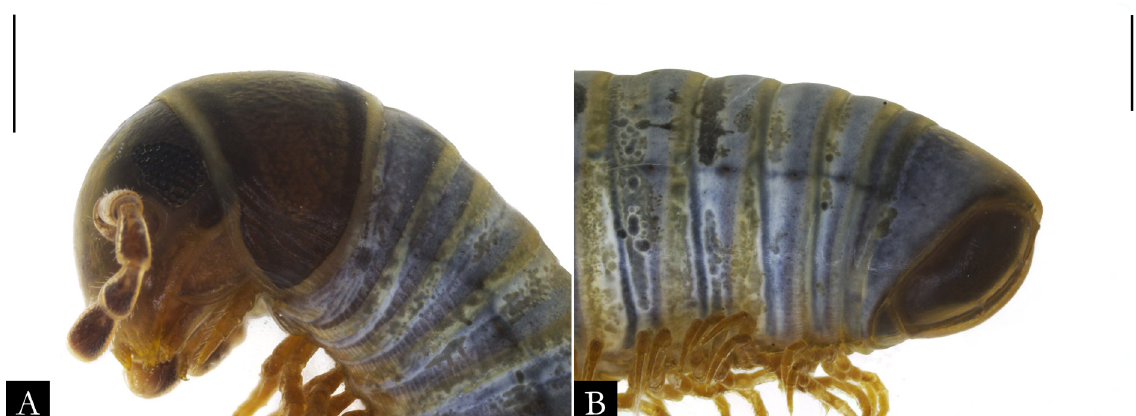
Fig. 140. Pseudonannolene urbica Schubart, 1945, ♀ (IBSP 7887), in lateral view. A . Anterior region. B . Posterior region. Scale bars = 0.5